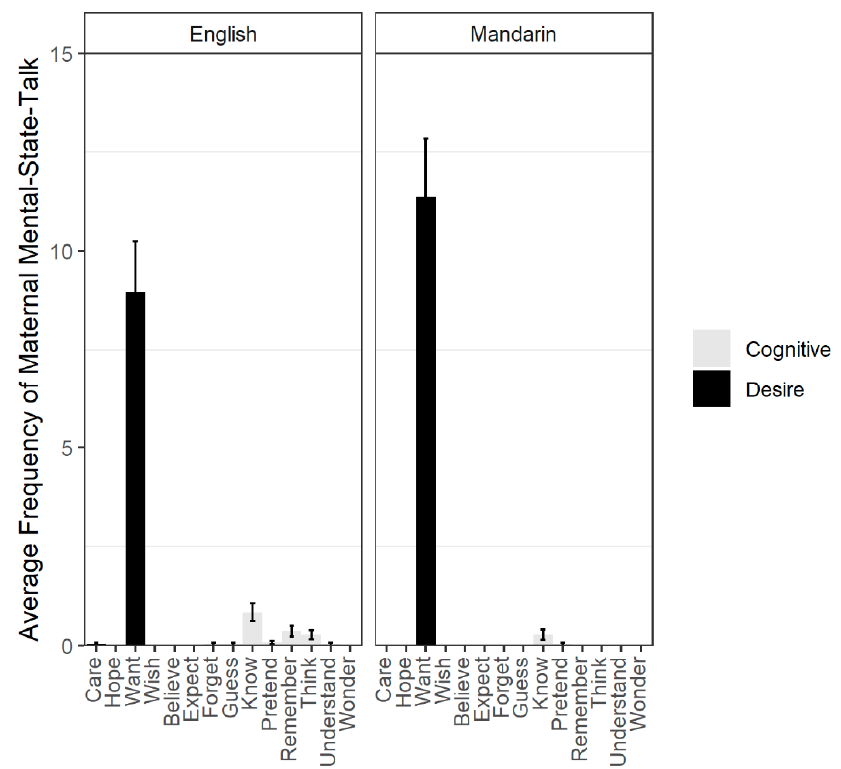
Figure 2. Average frequencies of maternal mental-state word across languages with error bars representing ± 1 standard error of the mean. Average frequency of mothers’ English mental-state-talk is illustrated on left; average frequency of mothers’ Mandarin mental-state-talk is illustrated on right.